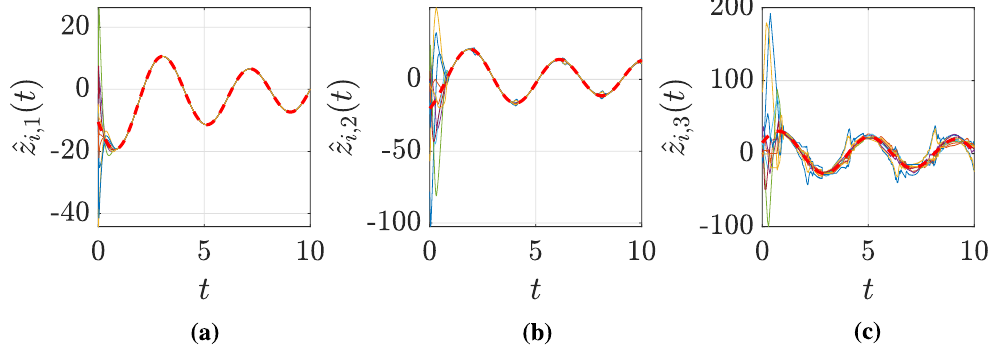
Figure 10. Consensus results for our protocol with ∆ = 10 − 4 , ε = 0.001, showing the estimates of the derivatives of first ( a ), second ( b ), and third ( c ) order. The derivatives ¯ z ( 1 ) ( t ) , ¯ z ( 2 ) ( t ) , ¯ z ( 3 ) ( t ) are plotted as a dashed red line. The error induced by the discretization and event-triggered communication is more apparent in higher-order derivatives, but the estimates are greatly improved with respect to the linear protocol (compare to Figure